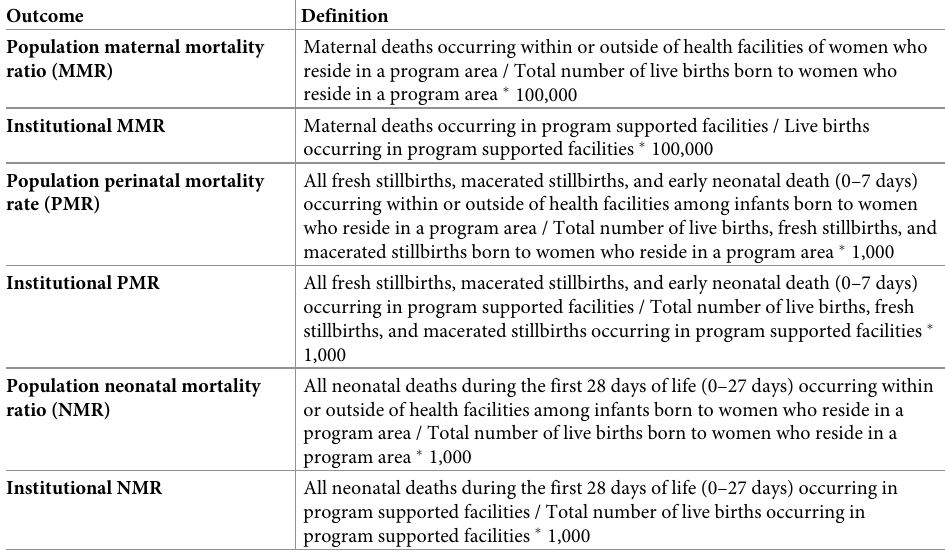
Table 3. Definitions of mortality outcomes